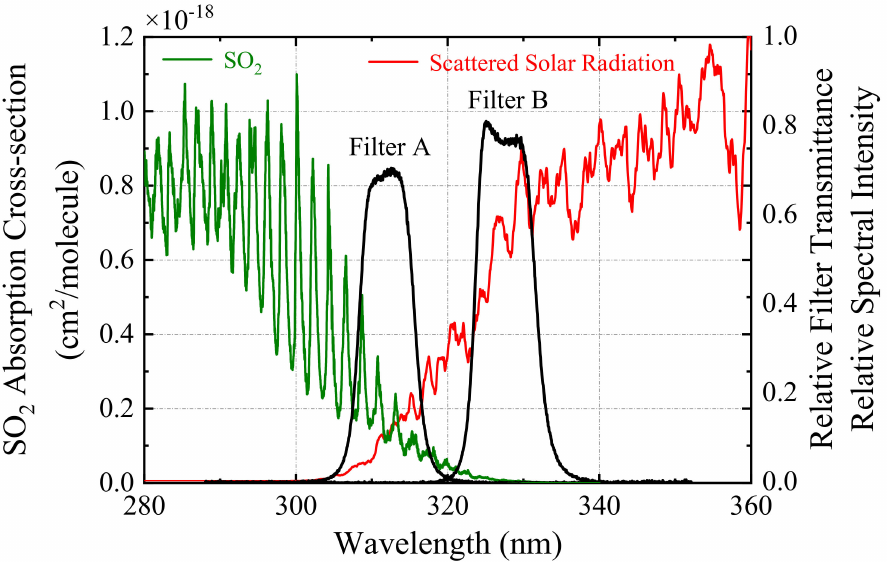
Figure 1. The absorption cross-sections of SO 2 and solar scattering spectrum. As a reference, the transmittance curves of filters at the wavelengths of 310 nm and 330 nm are also